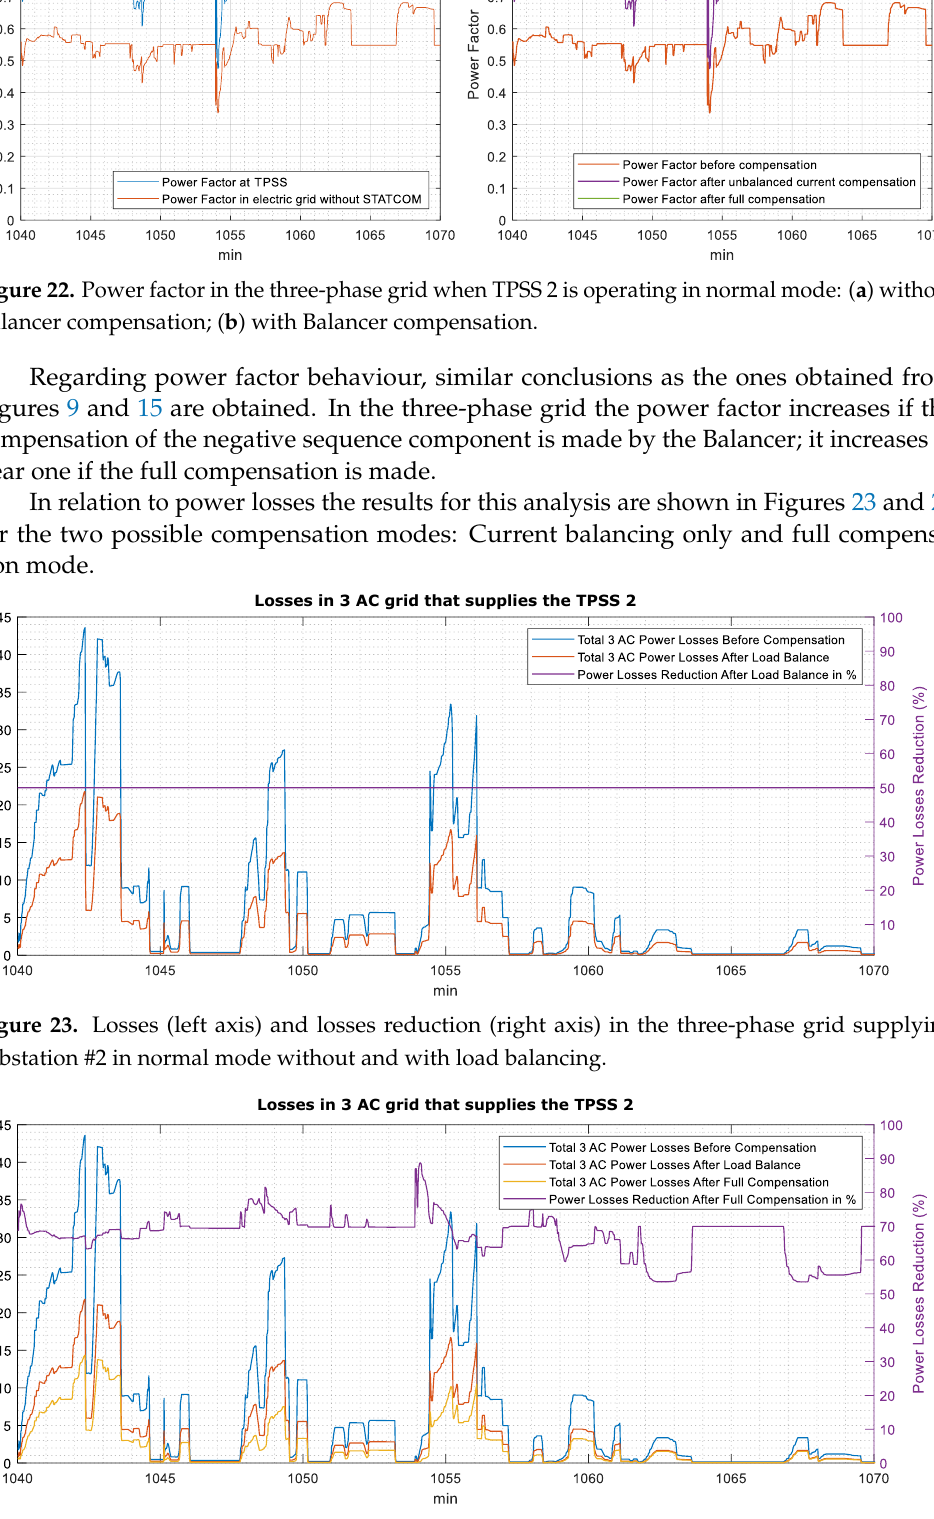
Figure 24. Losses (left axis) and losses reduction (right axis) in the three-phase grid supplying substation #2 with different compensation